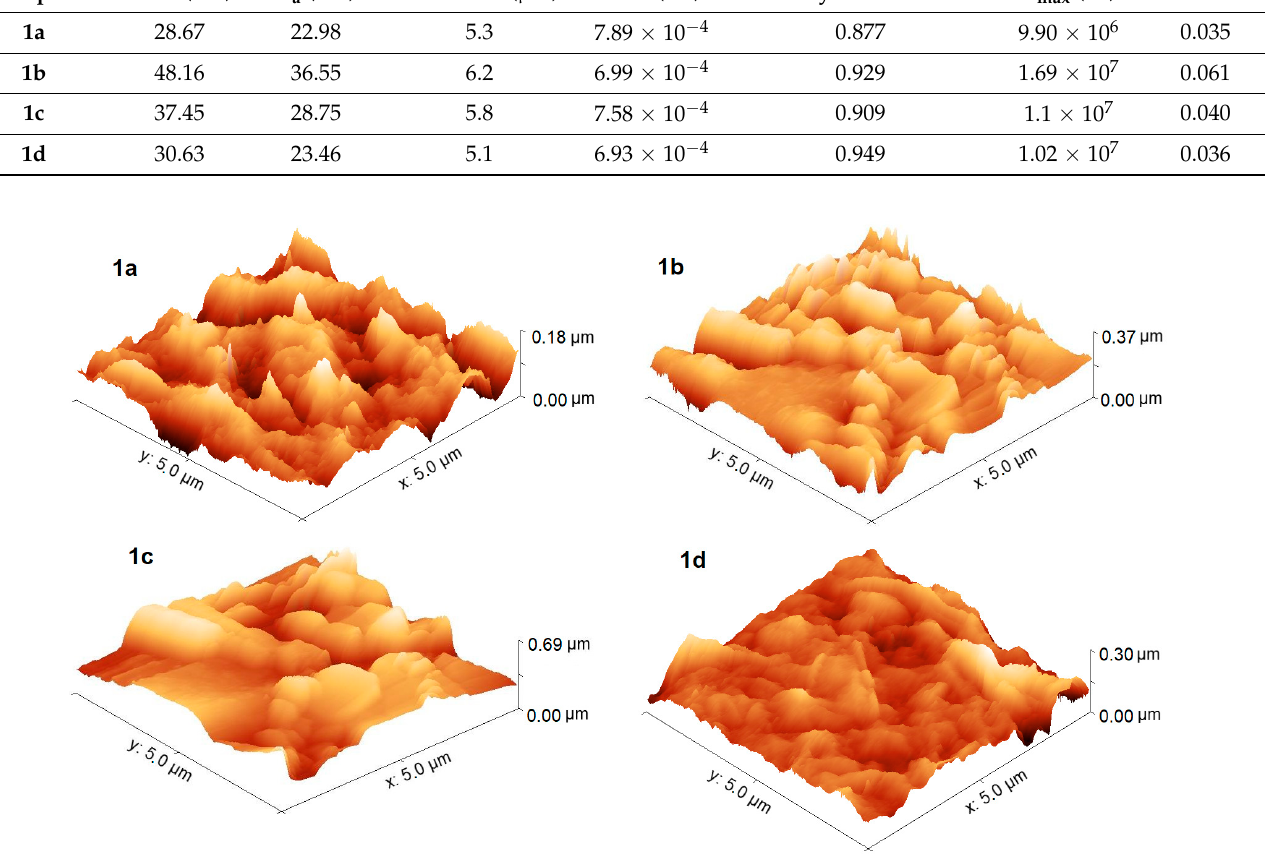
Figure 5. AFM topography of PEDOT:PSS-graphene-organotin(IV) Table 4. Roughness, dimensions and mechanical parameters of hybrid films.